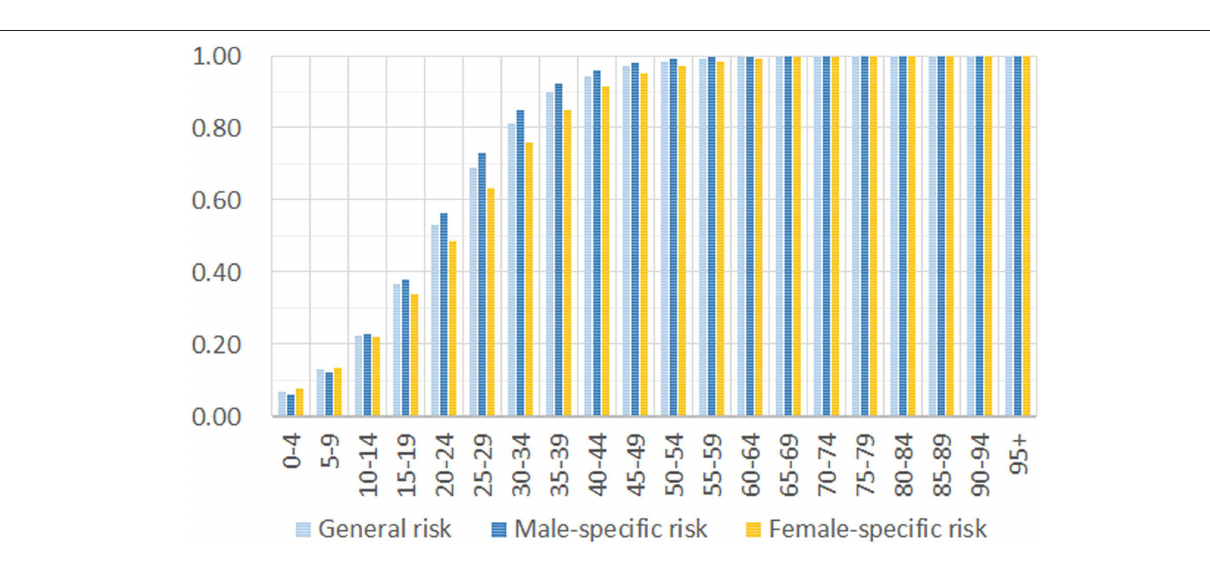
FIGURE 2 | Incidence risk increases in older groups of the general